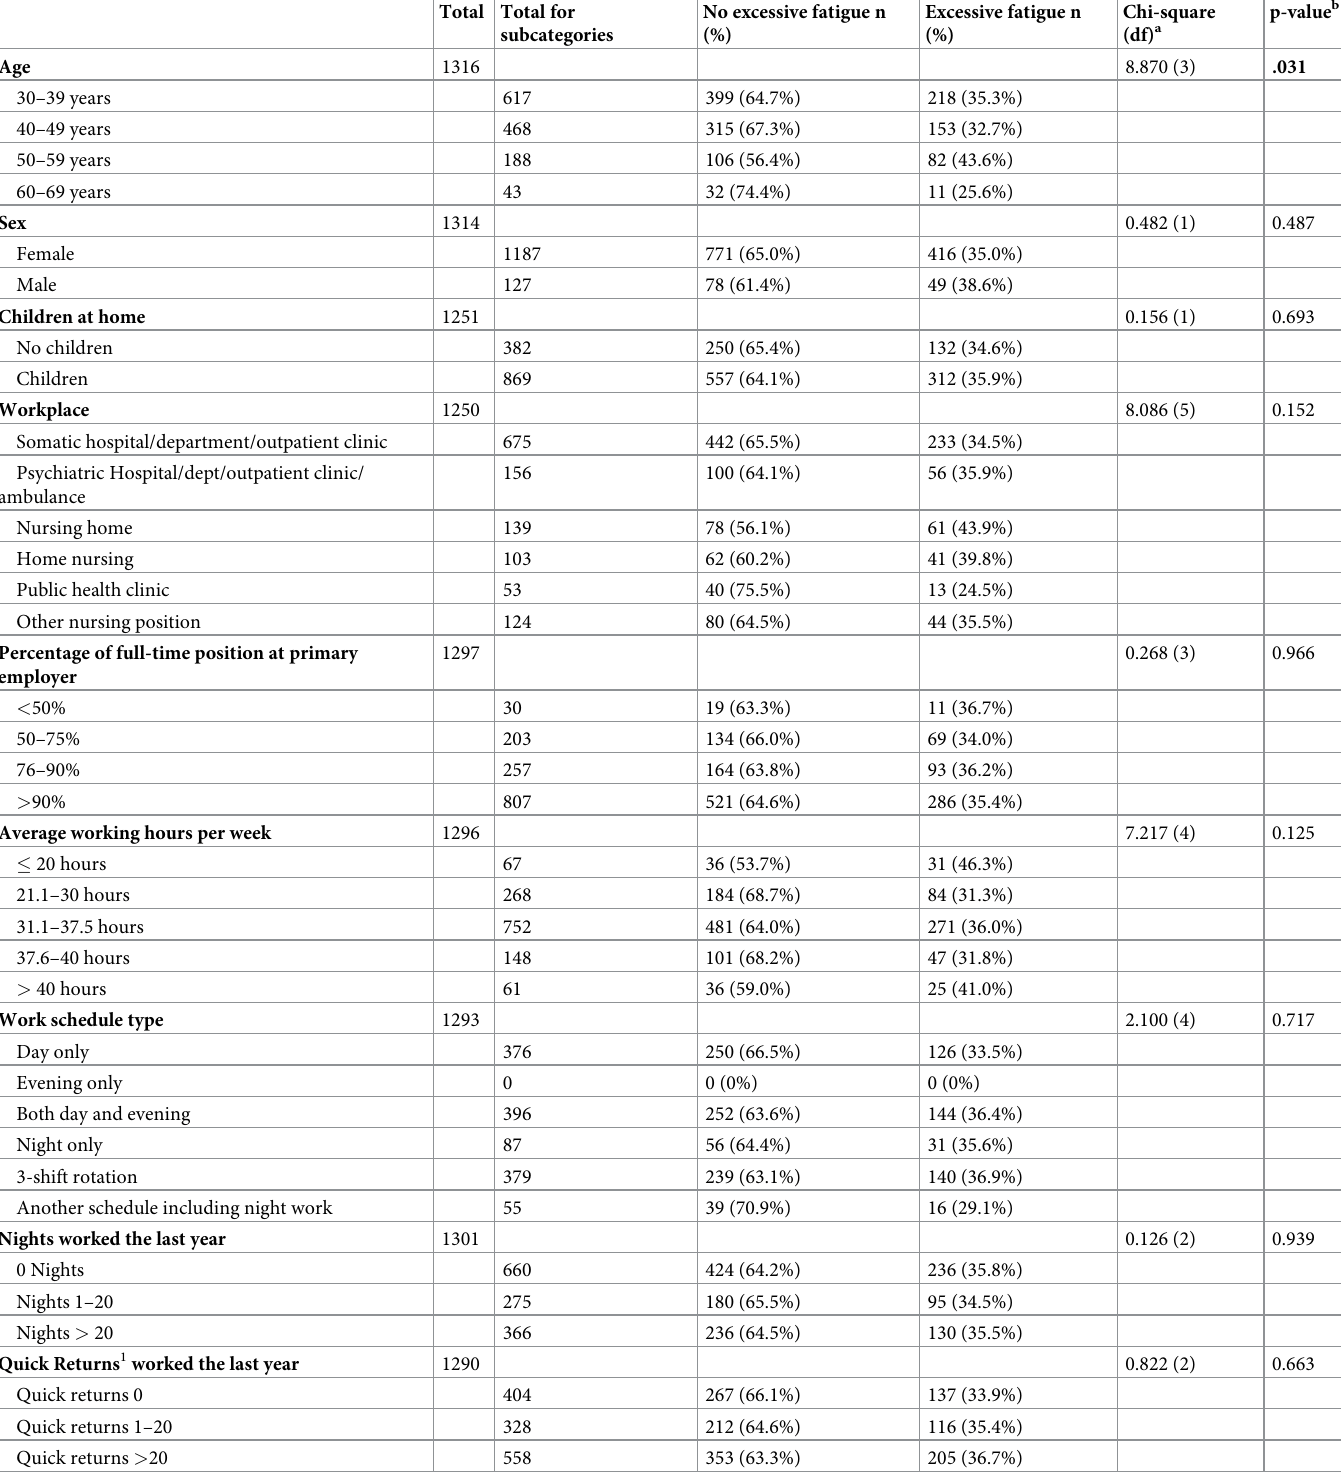
Table 3. Excessive fatigue depending on demographics, sleep, work-related variables and health issues among 1335 Norwegian nurses participating in the survey of shift work, sleep and health, wave 10